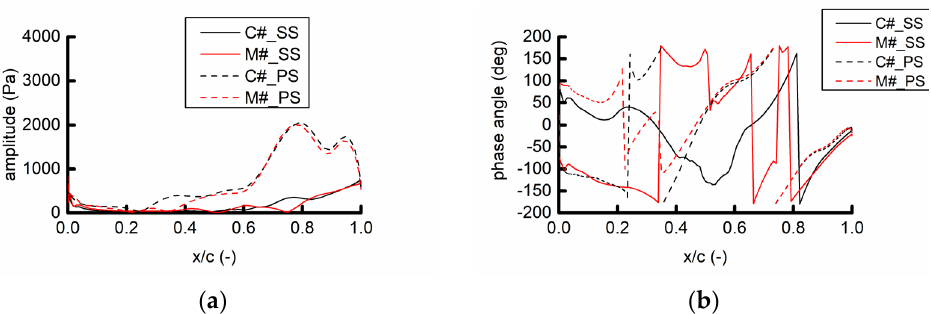
Figure 27. 45 EO component of static pressure at 50% blade span of R1 rotor blade. ( a ) Amplitude ( b ) Phase angle. ( b ) Phase angle.